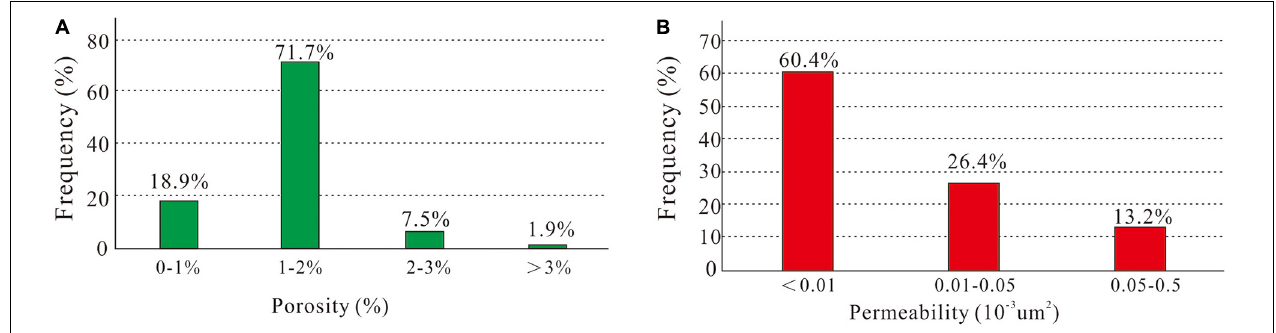
FIGURE 5 | Porosity (A) and permeability (B) histograms of the Longmaxi Formation shale in the Sichuan Basin.